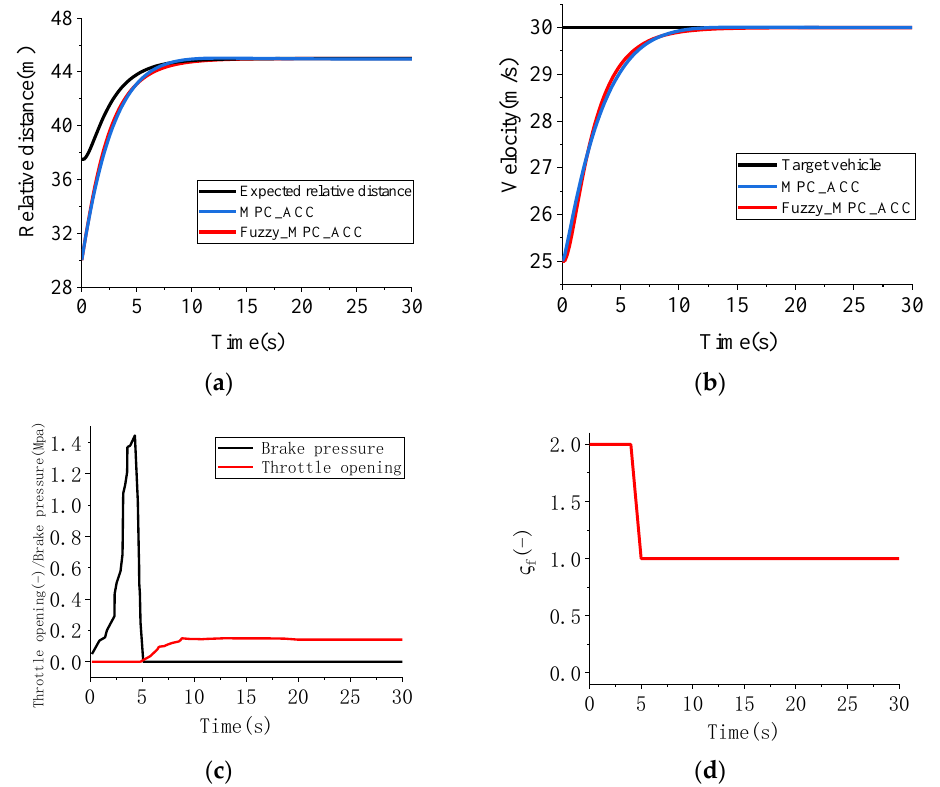
Figure 8. Acceleration conditions: ( a ) speed; ( b ) relative distance; ( c ) throttle opening/brake pressure; ( d ) weight coefficient ς f .